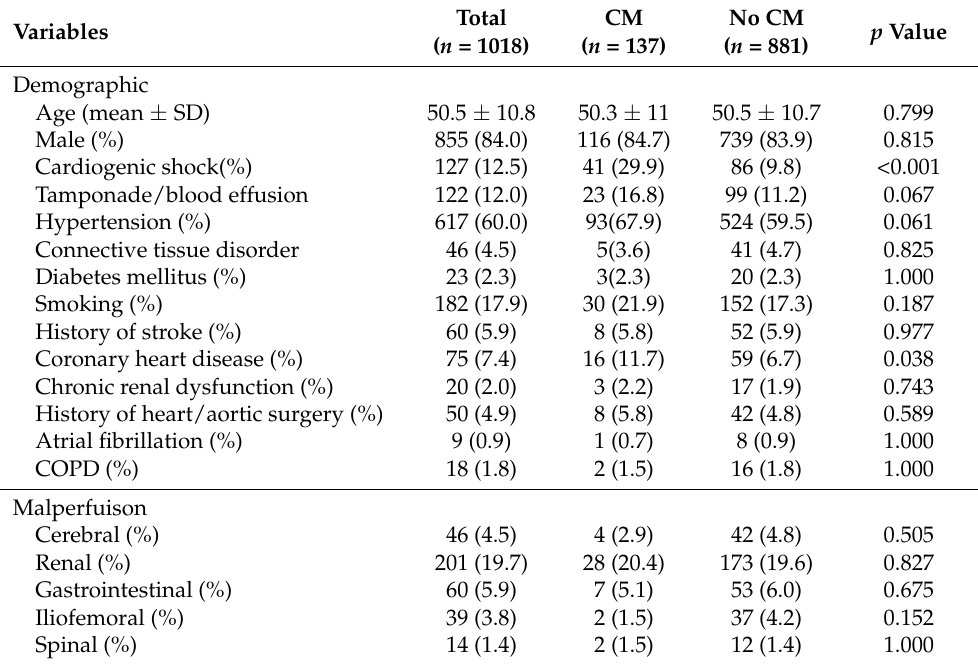
Table 1. Preoperative characteristics of the entire cohort.